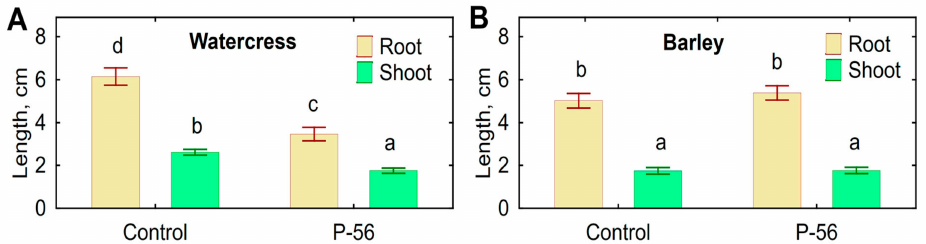
Figure 6. Effect of leaf cells of Streptomyces sp. P-56 on root ( A ) and shoot ( B ) length of barley and watercress seedlings. Vertical bars show standard error. Different letters show significant differences between treatments (least significant difference test ( p < 0.05, n =